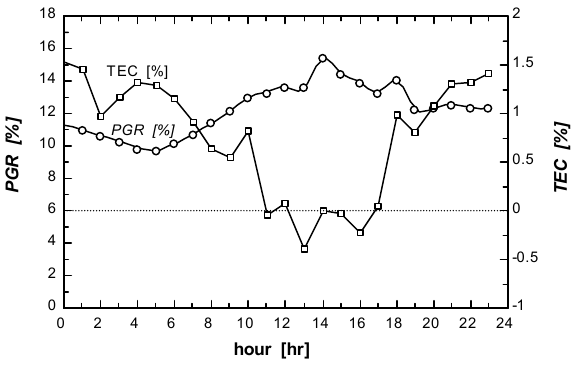
Fig. 7. Variation of gas turbine PGR and TEC during 18 th August